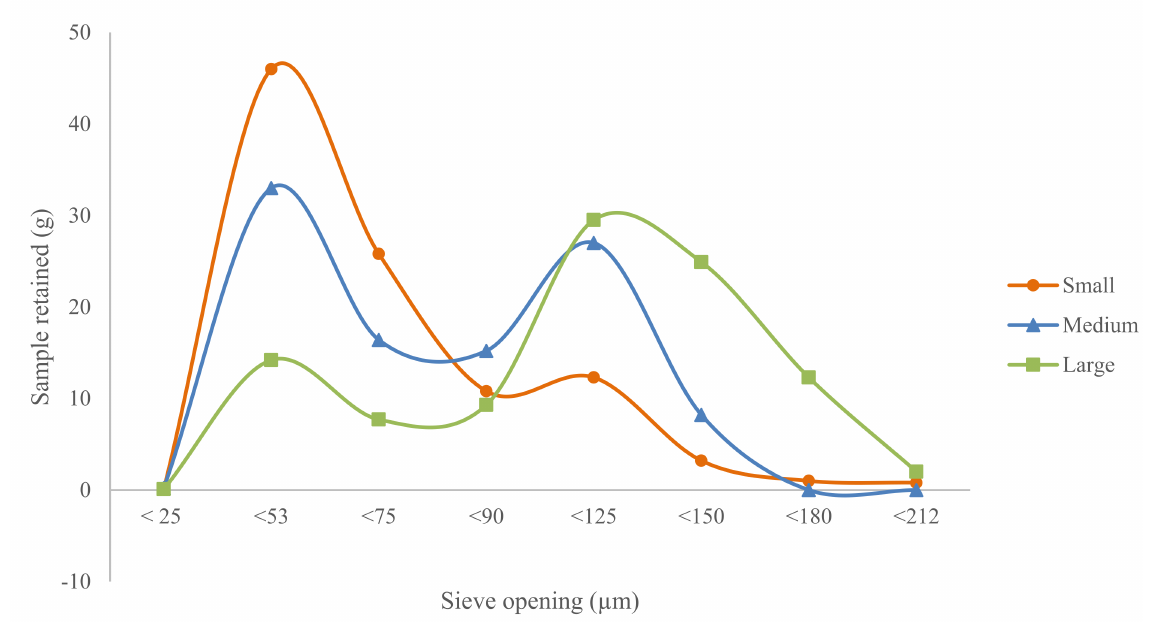
Figure 3. Particle size distribution of small, medium, and large red lentil flour.